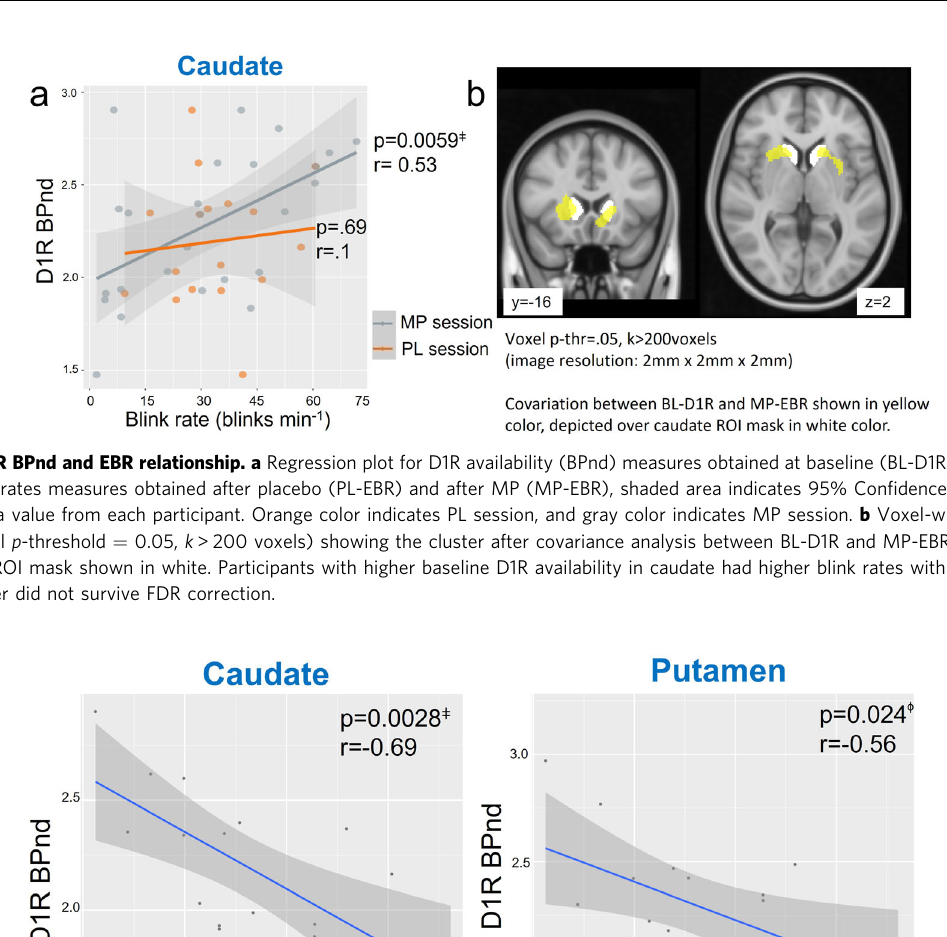
did not show signi fi cant correlations with the PL EBR measure (PL-EBR; caudate: r(15) = 0.1, p = 0.69; putamen: r(15) = − 0.28, p = 0.028; VS: r(15) = − 0.37, p = 0.14;) but showed a signi fi cant positive correlation with EBR obtained after MP (MP-EBR) in the caudate r(23) = 0.53, p < .01, whereas correlations in putamen (r(23) = 0.31, p = 0.13) and VS (r(23) = 0.03, p = 0.89) were not signi fi cant (Fig. 3).